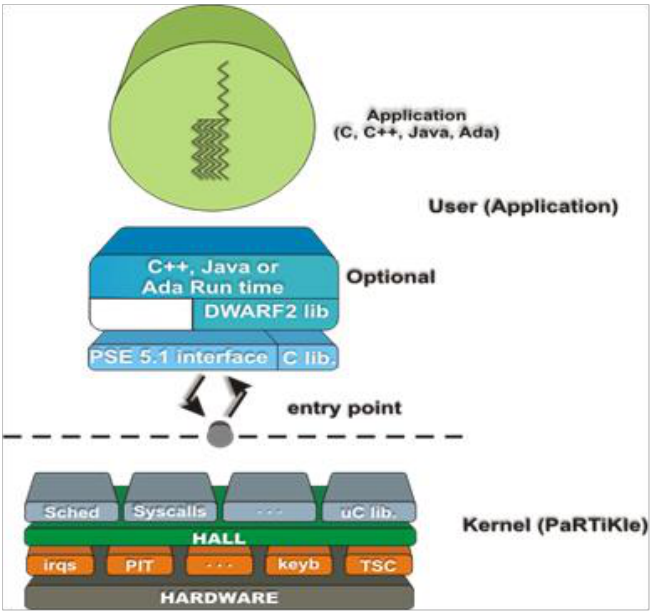
Figure 2. PaRTiKle OS